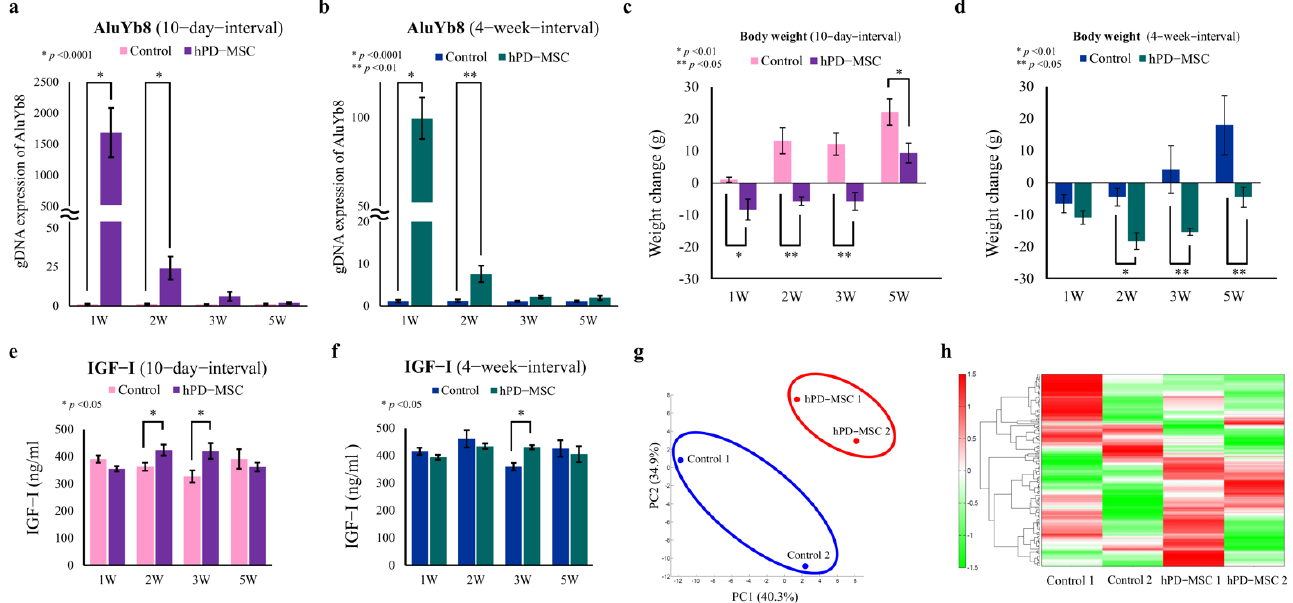
Figure 1. hPD-MSC therapy ameliorates aging-associated phenotypes through numerous metabolic pathways in advanced-age rat models. ( a , b ) Analysis of human cells after multiple injections of hPD-MSCs into aged rats by using qRT–PCR. Human DNA ( AluYb8 ) expression was detected in the liver after multiple injections of hPD-MSC therapy at 10-day intervals ( a ) or 4-week intervals ( b ). The results show that hPD-MSCs were located in the liver 1–2 weeks after multiple-injection therapy. ( c , d ) Changes in body weight after hPD-MSC therapy. Aged rats after multiple injections of hPD-MSC therapy at 10-day intervals or 4-week intervals showed body weight reduction and long-term maintenance. Data are presented as the mean ± SEM. The asterisk represents statistical significance at p < 0.05. Control, PBS-injected group; hPD-MSCs, multiple-injection hPD-MSC therapy group. ( e , f ) Serum levels of IGF-I, a key regulator of aging, after hPD-MSC therapy. ( g ) PCA of serum metabolite profiles from CE-TOF/MS analysis of aged female rats after hPD-MSC therapy. Serum samples were collected at the 2nd week after three injections of PBS or hPD-MSCs. Control, PBS-injected group; hPD-MSCs, multiple-injection hPD-MSC therapy group. ( h ) Heatmap of the hierarchical cluster analysis of the metabolome analysis after multiple-injection hPD-MSC therapy. The columns indicate the experimental groups of control and multiple-injection therapy at a 10-day interval. The rows show the normalized levels of each metabolite. The dendrogram for each heatmap shows the relatedness of the normalized metabolite level